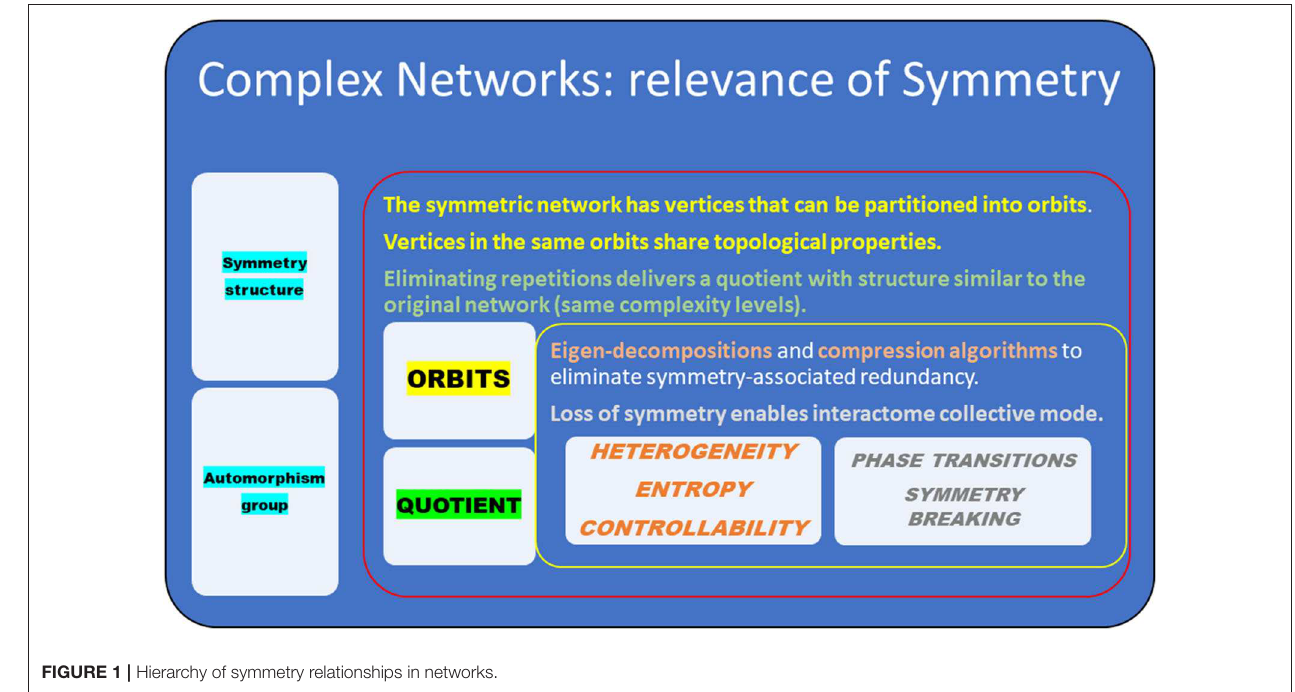
FIGURE 1 | Hierarchy of symmetry relationships in networks.